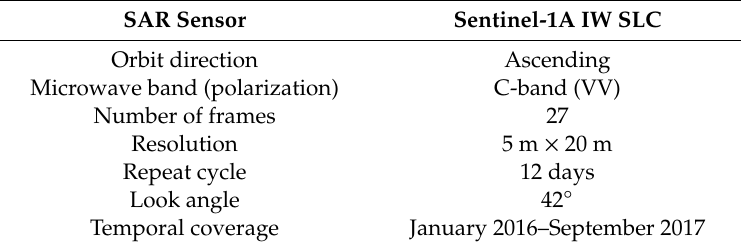
Table 1. The acquisition parameters of Synthetic Aperture Radar (SAR) data.